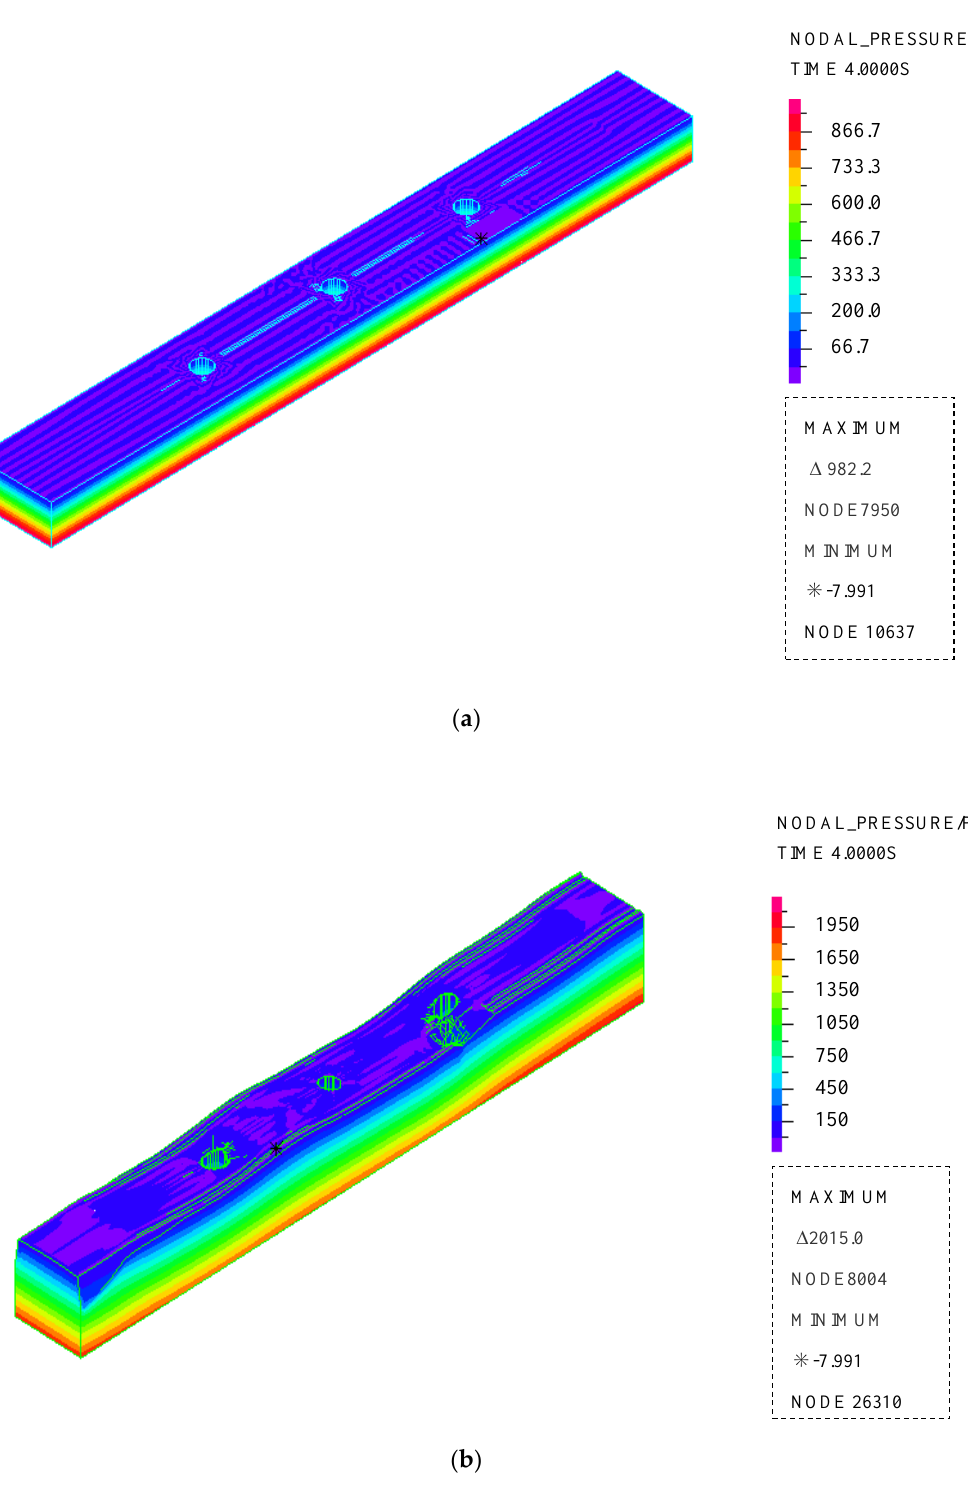
Figure 11. Fluid pressure cloud maps ( a ) Laminar flow model; ( b ) Turbulence model.